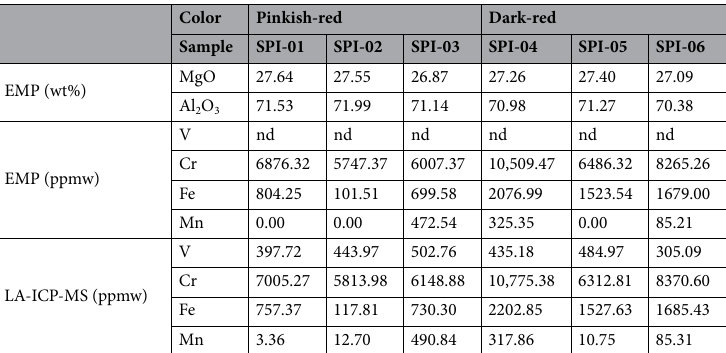
Table 1. EMP and LA-ICP-MS data for six studied spinel crystals. nd not detected.